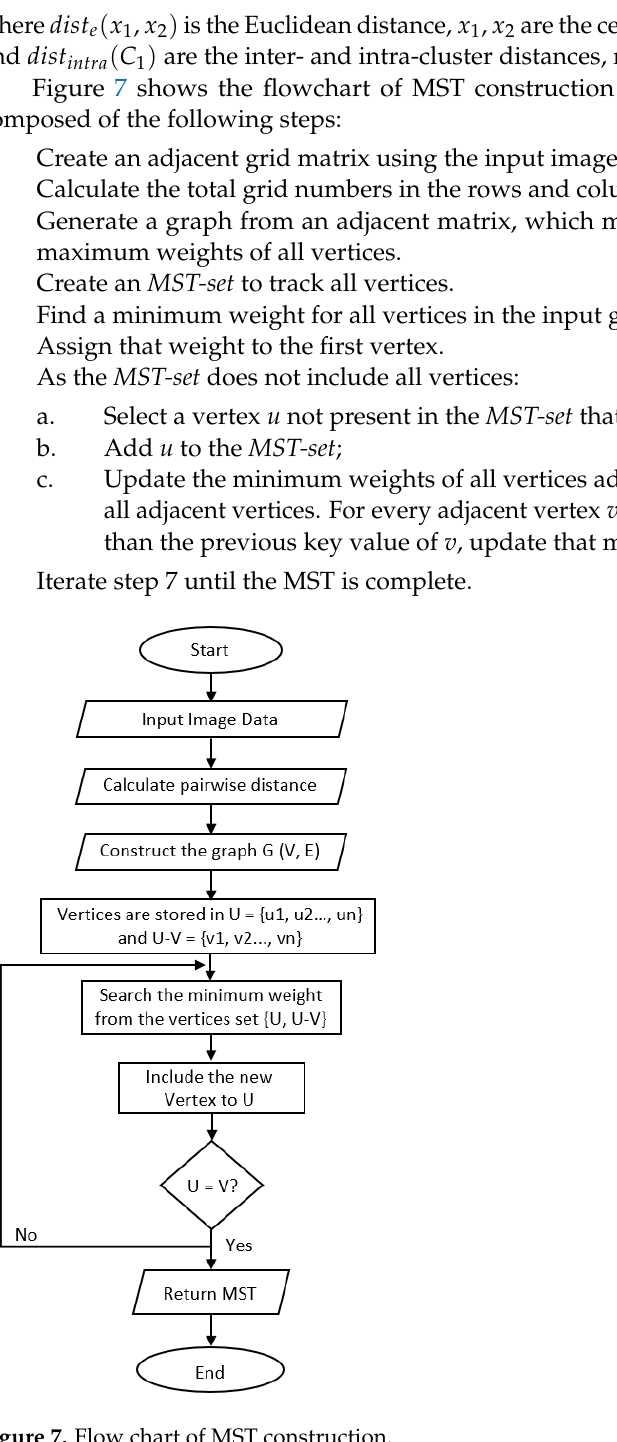
Figure 7. Flow chart of MST construction.